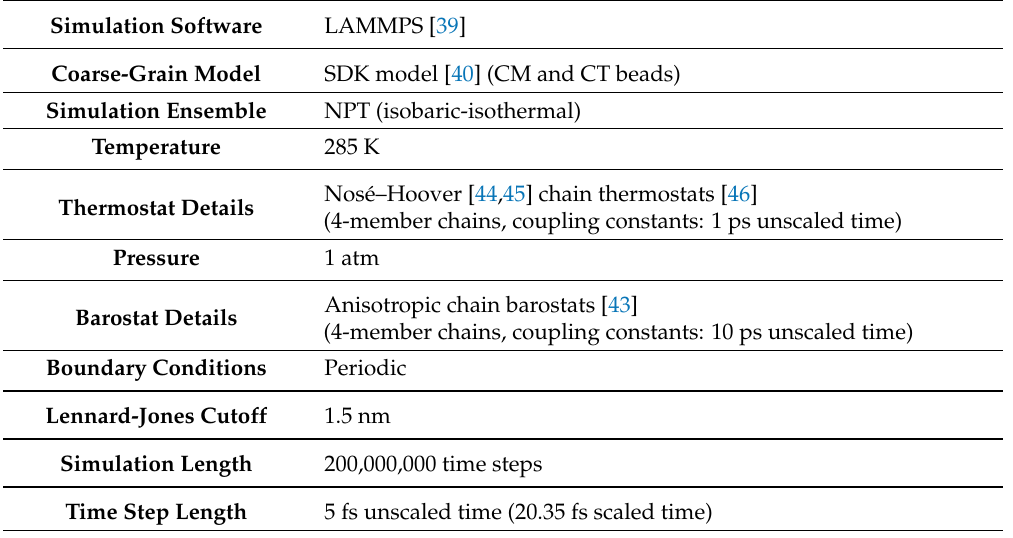
Table 1. Simulation details for the nucleation simulations. The unscaled times indicate the times that were used in the LAMMPS input files, whereas the scaled times include the scaling factor of